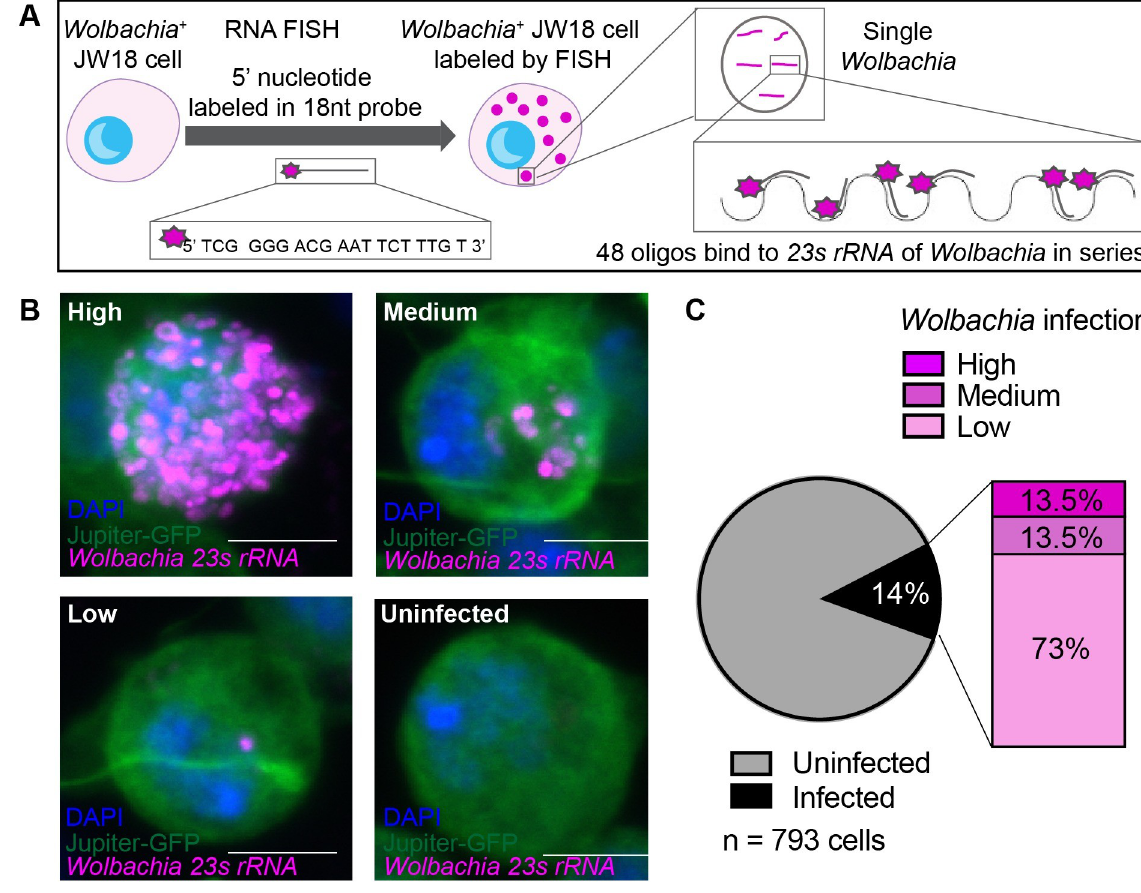
Fig 1. Visualization of infection dynamics in the JW18 cell line. (A) Schematic of Wolbachia detection by RNA Fluorescent In Situ Hybridization (FISH) using a sensitive and specific set of 48 5’-fluorescently-labeled oligos that bind in series to the 23s rRNA of the Wolbachia within a host cell. ( B) Wolbachia -infected JW18 cells labeled by 23s rRNA FISH probe can detect different infection levels in a highly specific manner. Scale bar 5 μ m. ( C) Wolbachia infection within the JW18 population is steadily maintained at 14% of the total cells in the population. Of the Wolbachia infected cells, the majority (73%) of cells have a low Wolbachia infection (1–10 bacteria per cell), 13.5% contain a medium Wolbachia infection (11–30 bacteria), and 13.5% of the infected JW18 cells have a high infection level ( > 30 bacteria) (n = 793 cells). See S1–S3 Figs for further characterization of JW18 cells.